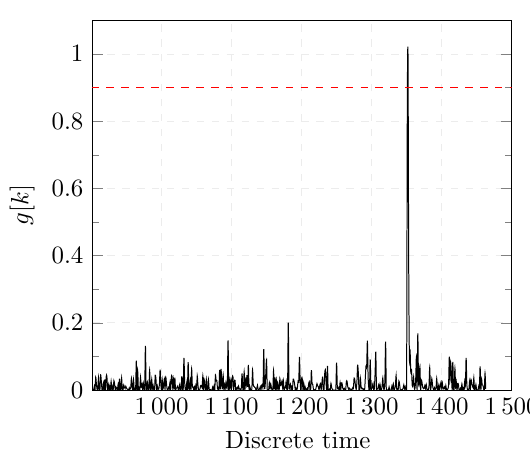
Figure 9. Results of the GLRT detection test.